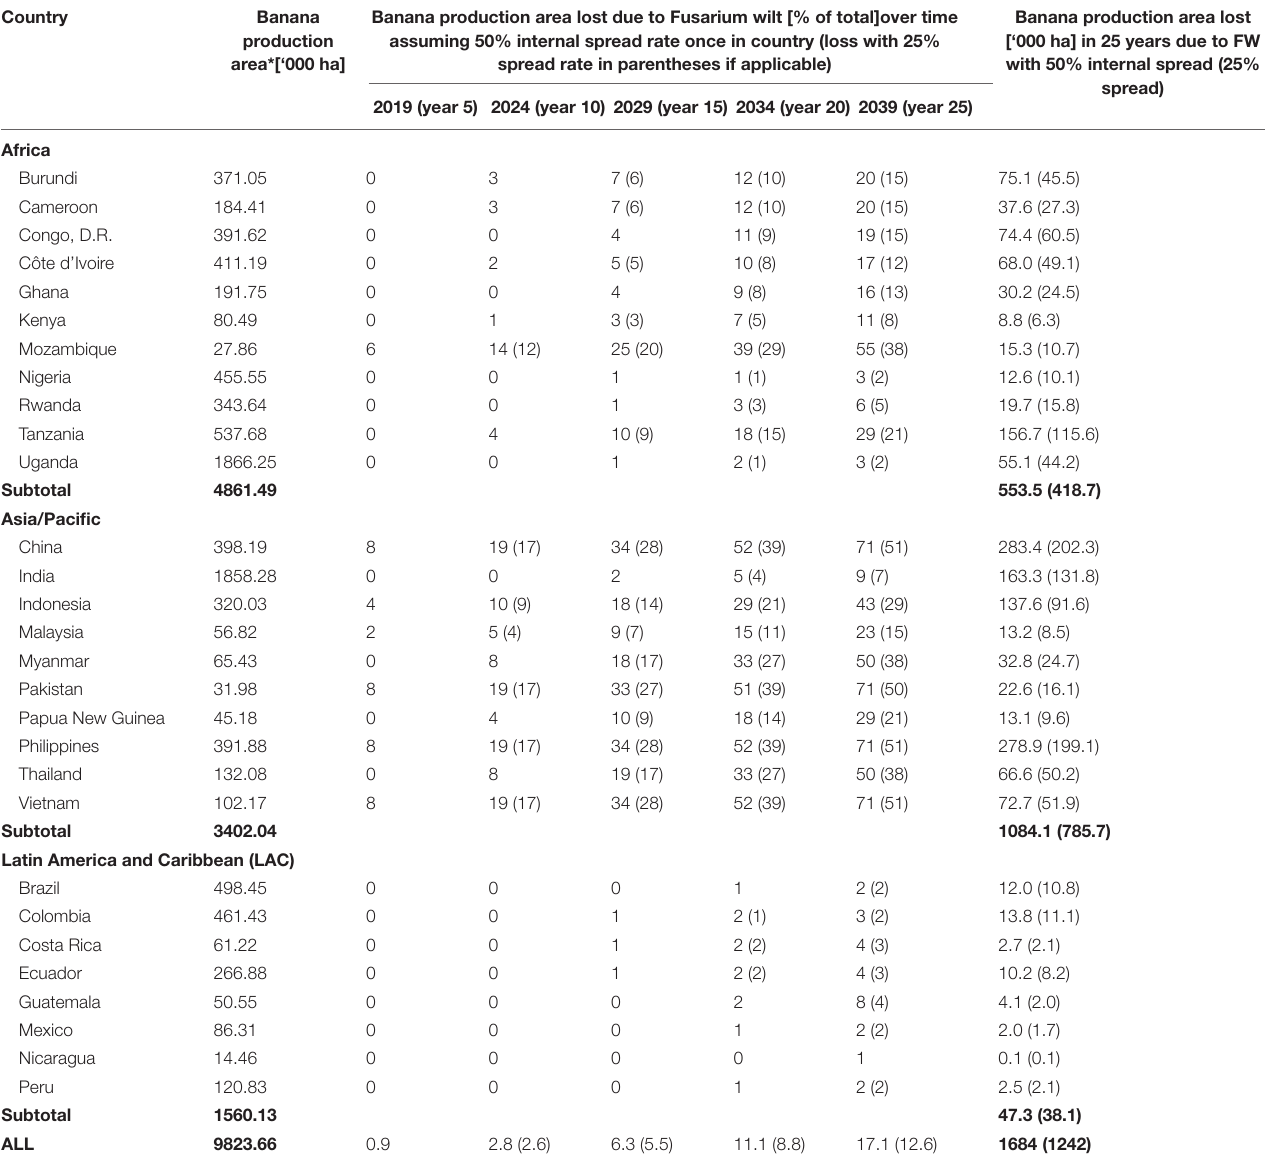
TABLE 3 | Estimated banana production area lost due to Fusarium wilt over time (by country and region). Country Banana